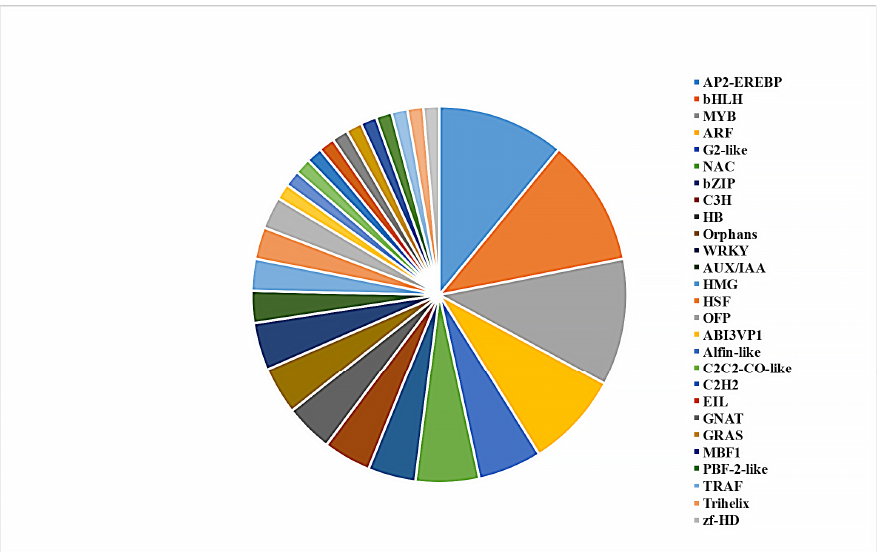
Figure 6. Identification of differentially expressed transcription factors with consistent expression patterns among the three rice cultivars.